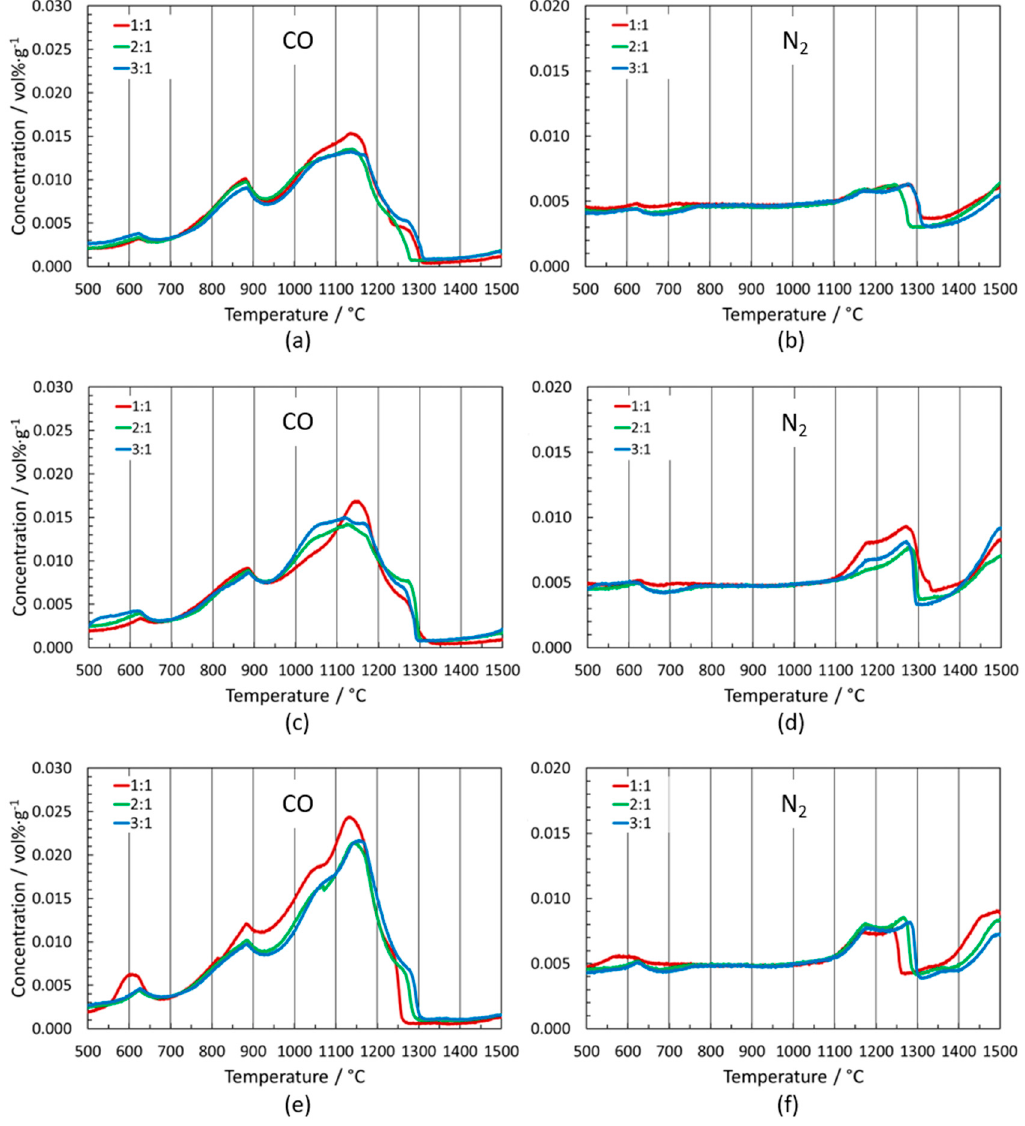
Figure 7. Left, ( a ), ( c ), ( e ): CO and right, ( b ), ( d ), ( f ): N 2 outgassing of cermet powder mixtures with different [Mo]/([Mo] + [W]) ratio (top, ( a ), ( b ): 0, centre, ( c ), ( d ): 0.5, bottom, ( e ), ( f ): 1.0 ) with pre-alloyed hard phase (Ti,W)C and/or (Ti,Mo)(C,N) and different Co:Ni ratio (1:1, 2:1 and 3:1), see Table 3.